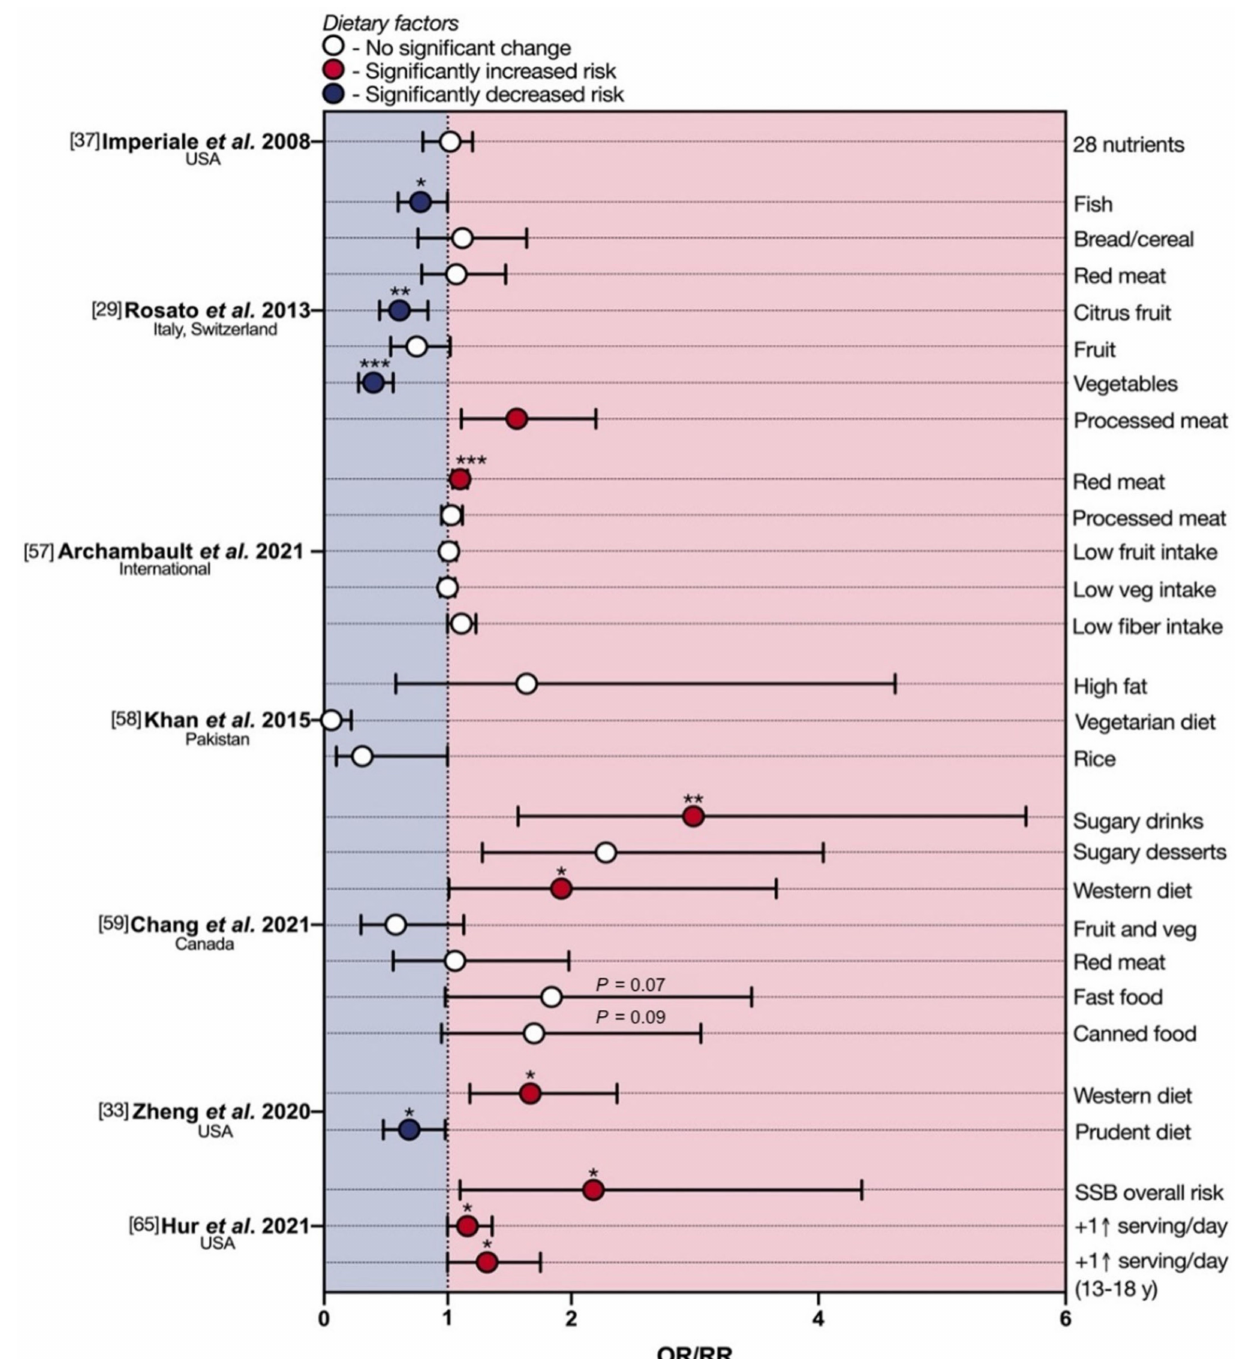
Figure 2. Protective and deleterious effects of diet in early-onset colorectal cancer. eoCRC—early-onset colorectal cancer; Met–meta-analysis; OR—odds ratio; RR—relative risk; SSB—sugar-sweetened beverage. * p < 0.05; ** p < 0.01; *** p <